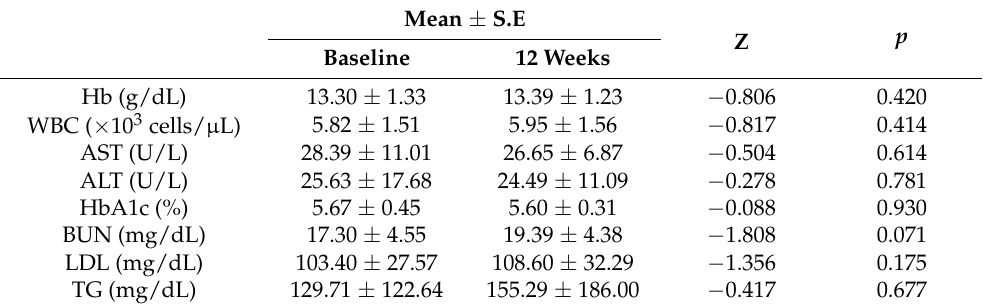
Table 5. Blood test changes within the intervention group ( n = 21) during the 12-week study period. Mean ±